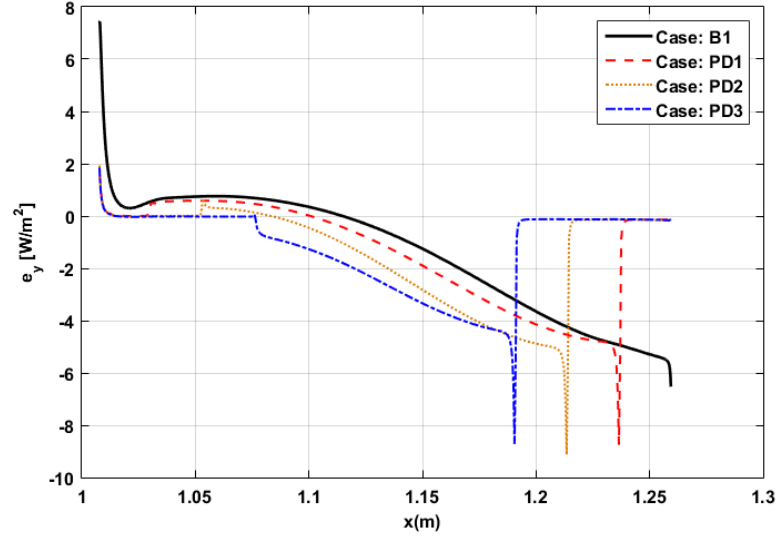
ff erent lengths combinations of multi-layered